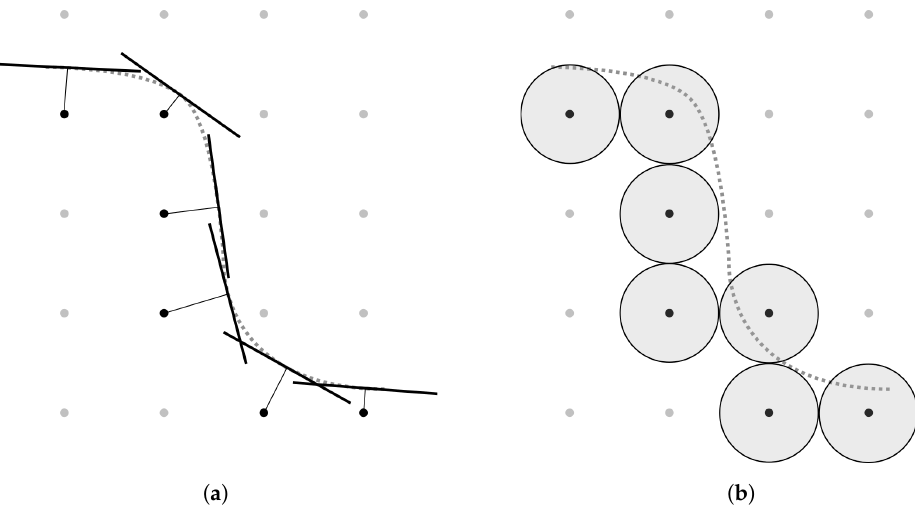
Figure 8. Two ways to approximate an implicit surface efficiently by explicit shapes on active grid points (black), in order to simplify intersection tests for ray tracing. The line segments and circles are replaced by disks and spheres in three dimensions. ( a ) tangential line segments used to form an explicit approximation of the surface, as described in [57]; ( b ) surface approximated by explicit circles centered at active grid points, as described in